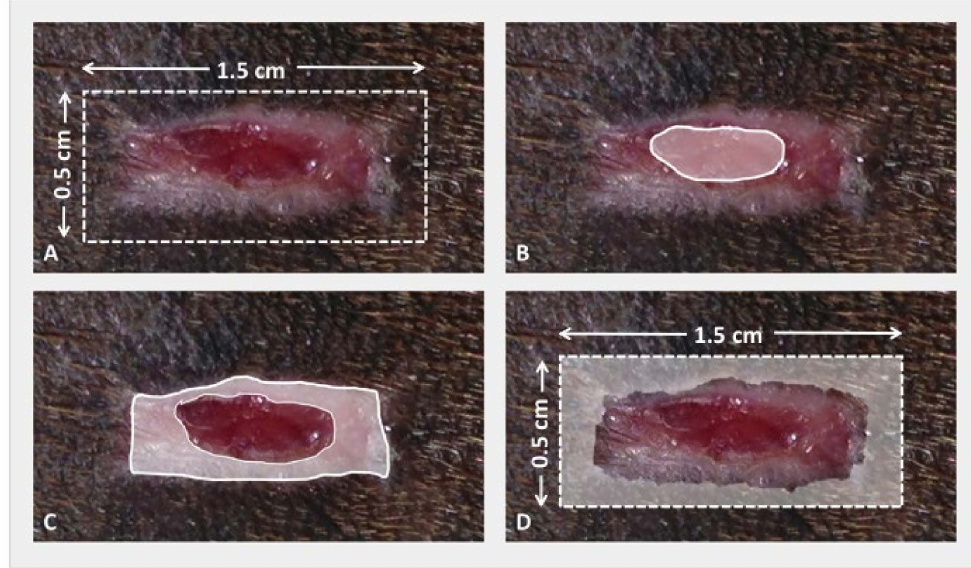
Figure 3. Representative diagram of measured areas of wound to determine proportion of wound closure by contraction and epithelialization using calibrated planimetric analysis: ( A ) representative area of the originally created wound (day 0) in relation to the current (day x) measured wound; ( B ) shaded area represents area of open granulation tissue; ( C ) epithelialization was determined by measuring the total area of nonhaired wound area and then subtracting open granulation tissue previously measured in ( B , D ) total contraction was determined by subtracting both the previously measured open granulation tissue in B and epithelialized tissue in C from the originally created wound size in A (day